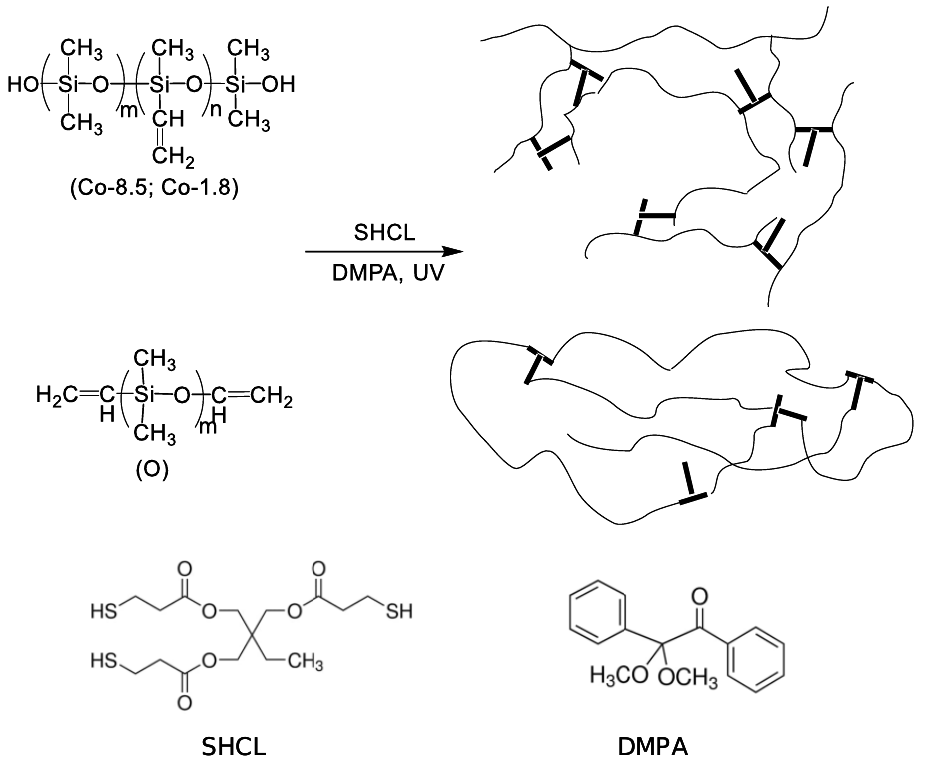
Scheme 2. Photo-initiated thiol-ene cross-linking reactions of vinyl silicones, and structures of the cross-linker (SHCL) and the photoinitiator (DMPA).